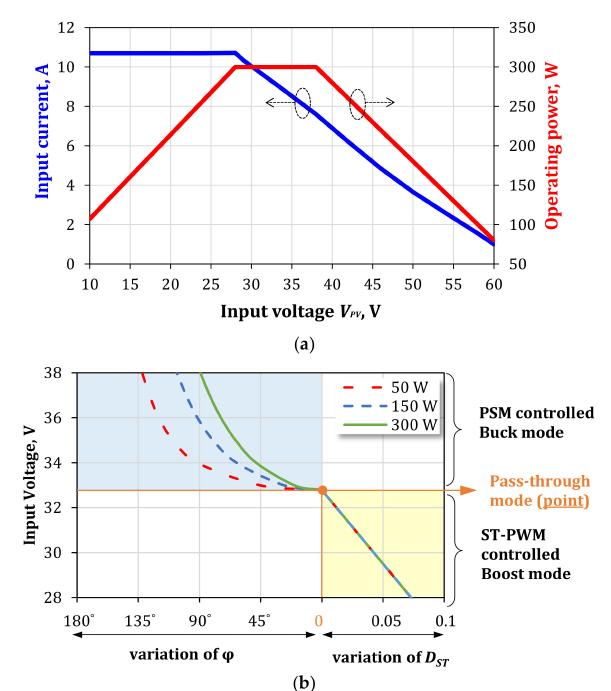
Figure 2. Operating power and input current profiles of the qZS IBBC based PVMIC ( a ) and its multimode control approach using the isolation transformer with turns ratio n = 6.1 ( b ).